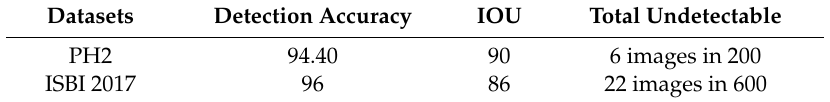
Table 2. Yolov3 skin lesion location detection performance (%) on the PH2 and the ISBI 2017.